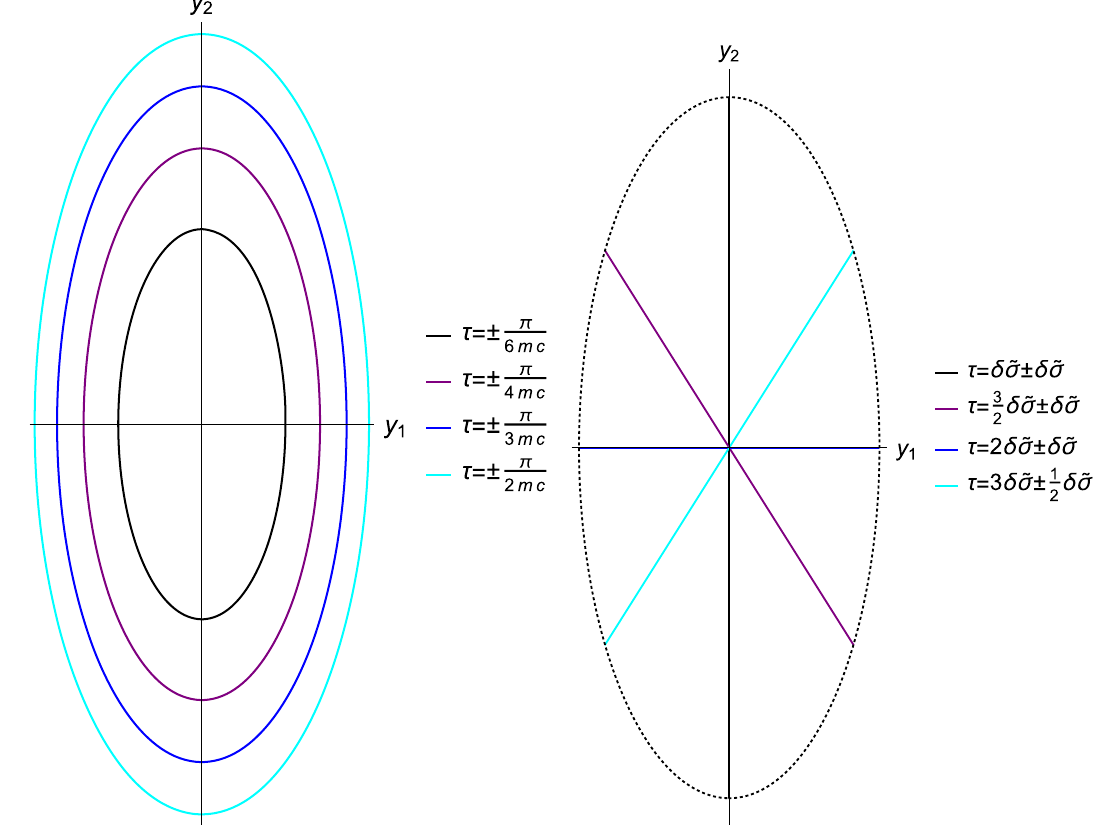
Fig. 5 Indicative rotating solutions of the SL ( 2 , R )/ U ( 1 ) A model. The left panel corresponds to a static solution, while the right one to a translationally invariant one, which is a folded string. The equation of the cyan ellipsis on the left panel and the dotted one on the right is (87)